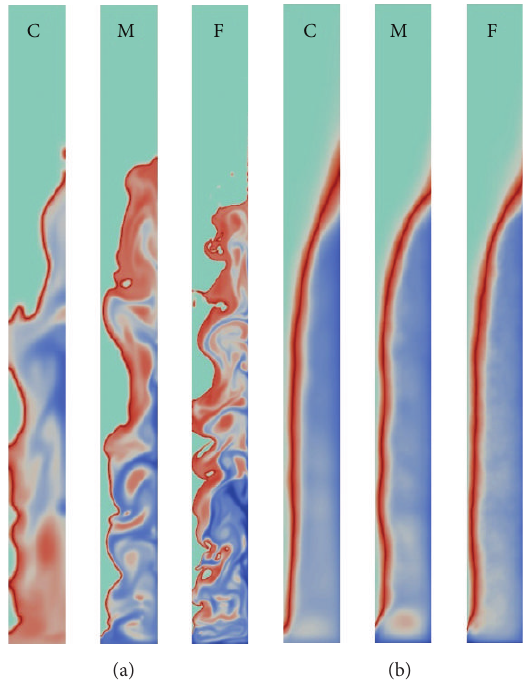
Figure 8: Snapshots of the phase fractions (a) at 𝑡 = 0.355 s after startup and (b) for a time average over the period from 𝑡 = 2 s to 𝑡 = 5 s for the three meshes.